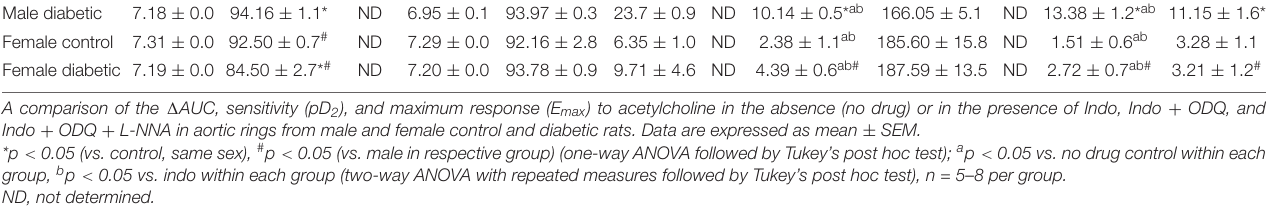
TABLE 3 | Area under the curve ( (cid:49) AUC), Sensitivity (pD 2 : -logEC50) and maximum response ( E max ) to ACh in rat aortic rings from male and female control and diabetic rats. Groups No drug Indo Indo + ODQ Indo + ODQ + L-NNA pD